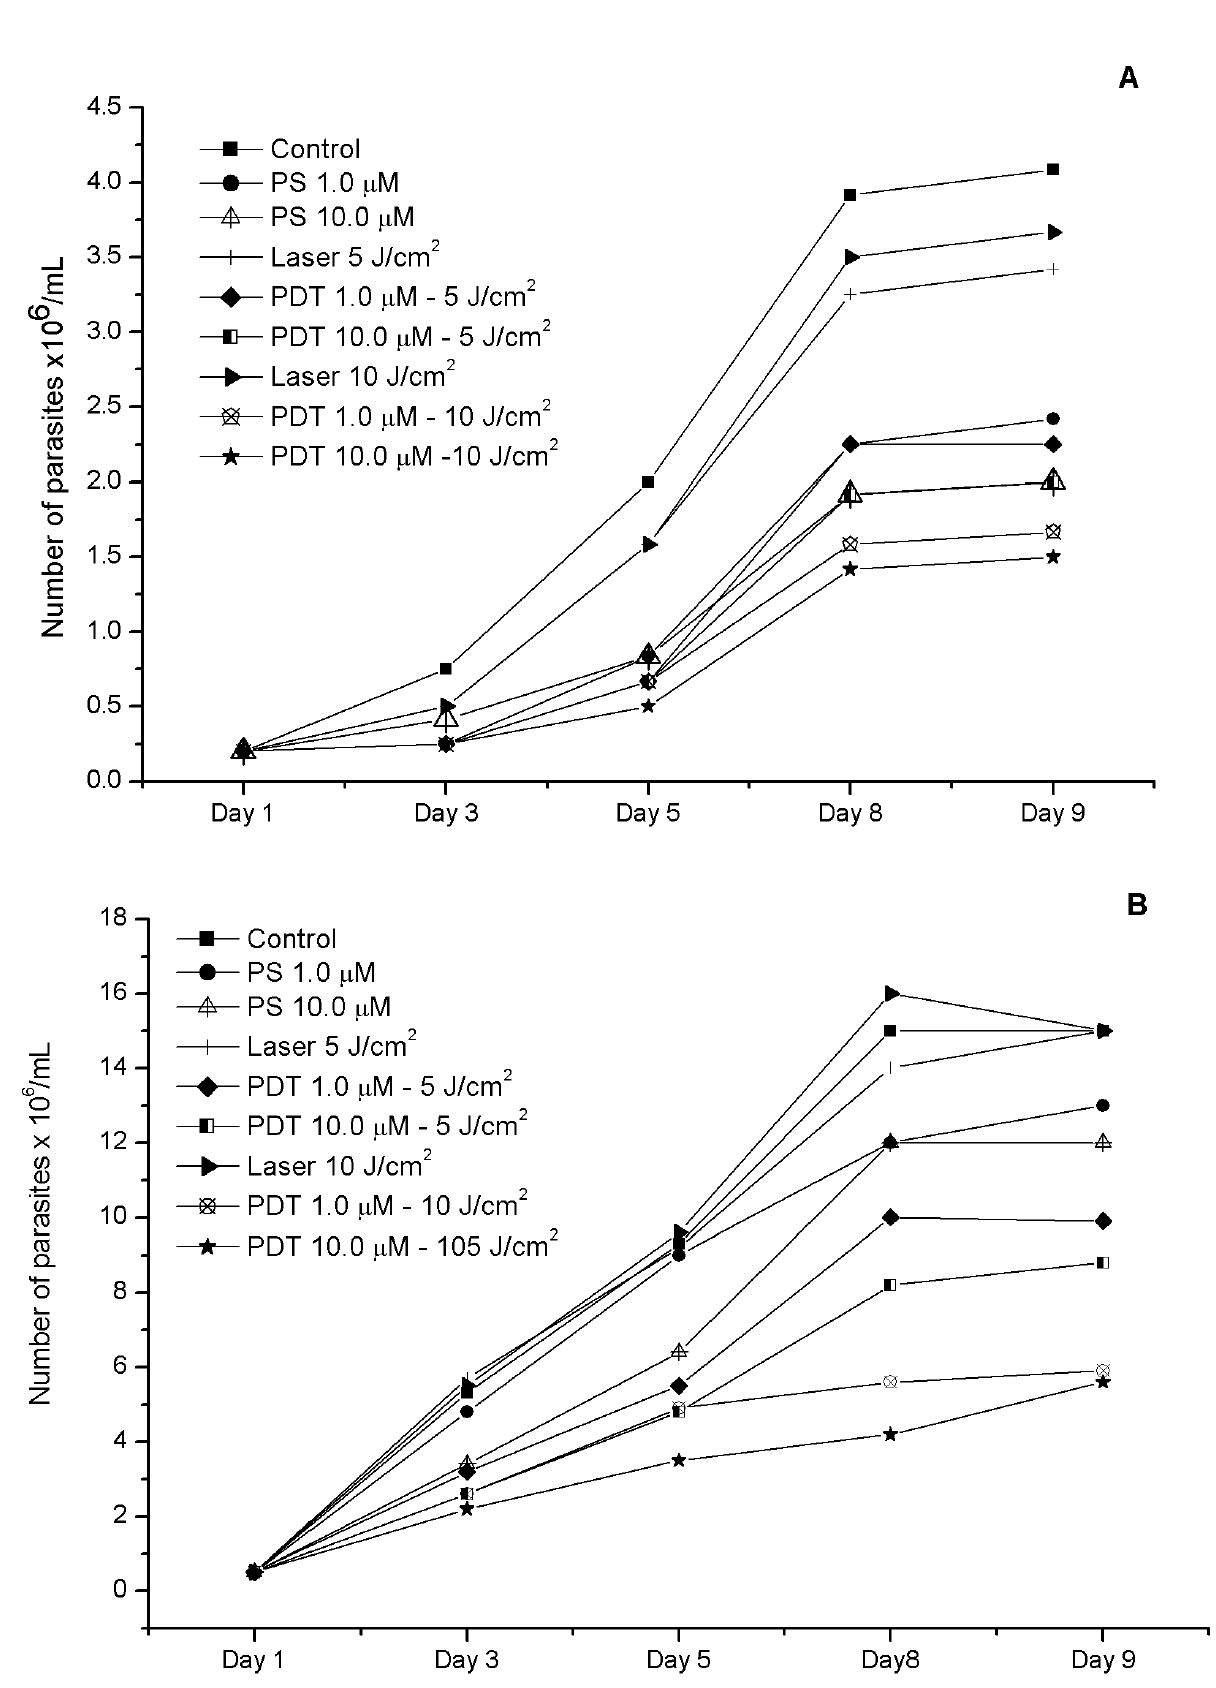
Figure 2. Growth curves for promastigotes after photodynamic treatment. ( A ) Growth curves for Leishmania major after PDT with AlPcS and laser at 5 J/cm 2 and after PDT with laser at 10 J/cm 2 . ( B ) Growth curves for 4 Leishmania braziliensis after PDT with AlPcS and Laser at 5 J/cm 2 and after PDT with AlPcS 4 J/cm 2